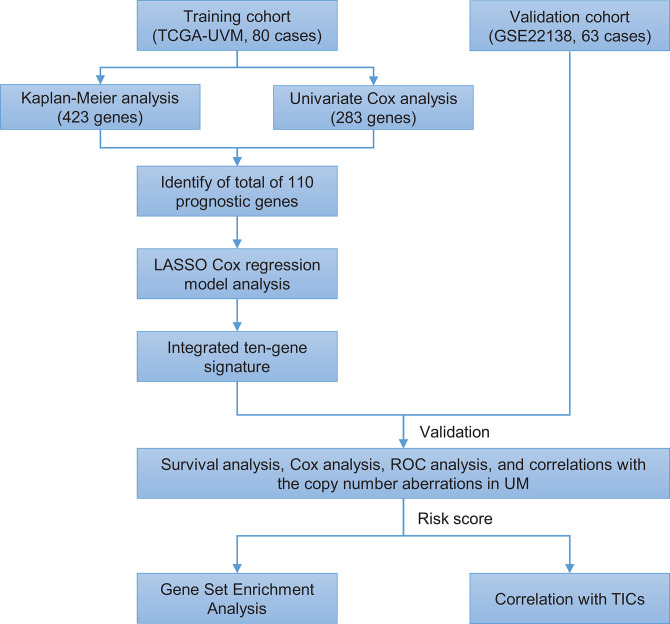
Brief flow chart of this study. The study was performed using TCGA-UVM and GSE22138 cohorts. The training cohort was applied to detect prognostic genes. LASSO regression model was for establishing a prognostic signature based on the prognostic genes. Then we validated the prognostic signature we established in the validation cohort. Finally, GSEA and TIC analysis were implemented to explore potential mechanisms further on the prognosis signature we found. LASSO, the least absolute shrinkage and selection operator Cox regression model; ROC, receiver operating characteristic; TICs, tumor-infiltrating immune cells; UM, uveal melanoma; GSEA, Gene Set Enrichment Analysis.